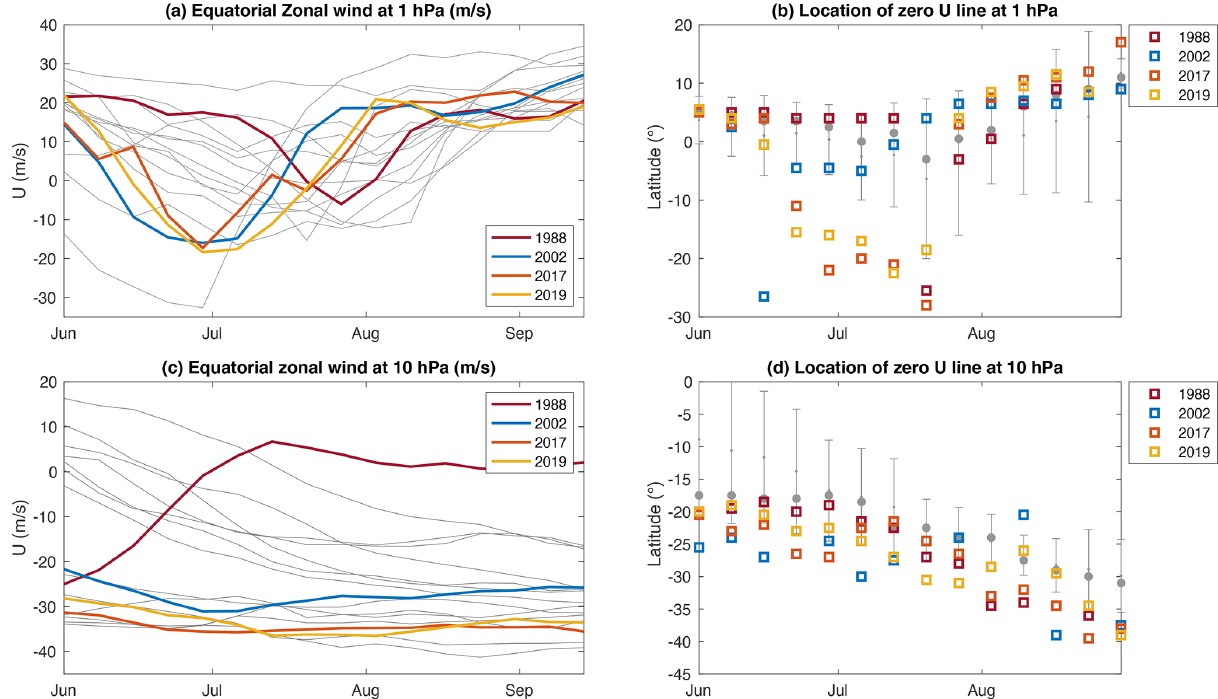
Figure 6. (a) Evolution of the equatorial (5 ◦ S–5 ◦ N) SAO zonal wind at 1hPa level (ms − 1 ) from June to September. The grey lines show the wind for all eQBO years with the years 1988, 2002, 2017, and 2019 highlighted with red, blue, orange, and yellow lines, respectively. (b) Latitudinal location of the zero zonal wind line at 1hPa level. The small grey dot indicates the mean location while the large grey circle indicates the median location during the eQBO years. For clarity, the grey bars show the 1 × σ deviation around the mean location. Years 1988, 2002, 2017, and 2019 are highlighted with red, blue, orange, and yellow markers, respectively. (c, d) The same as above but for the zonal wind at the 10hPa level for